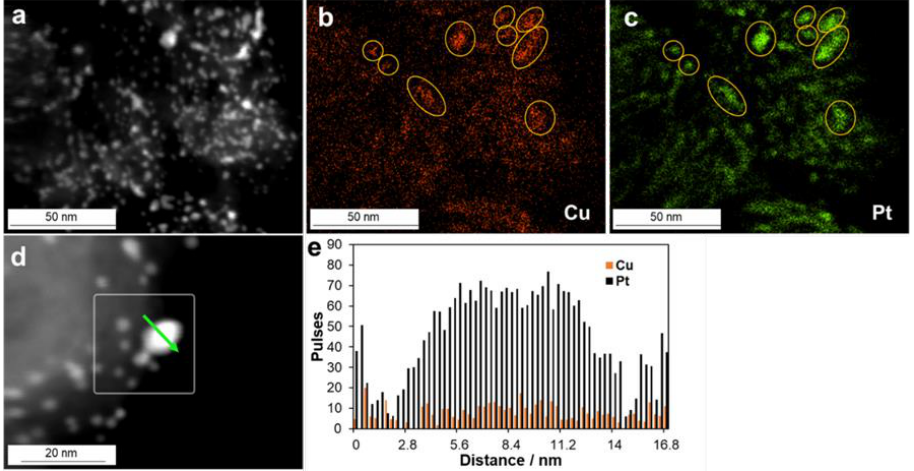
Figure 8. STEM images ( a , d ) and elemental mapping ( b , c ) of the PtCu/KB-N material after the stress test. The green arrow shows the direction of EDX line scanning ( d ). Composition of NPs according to the EDX line scan ( e ).